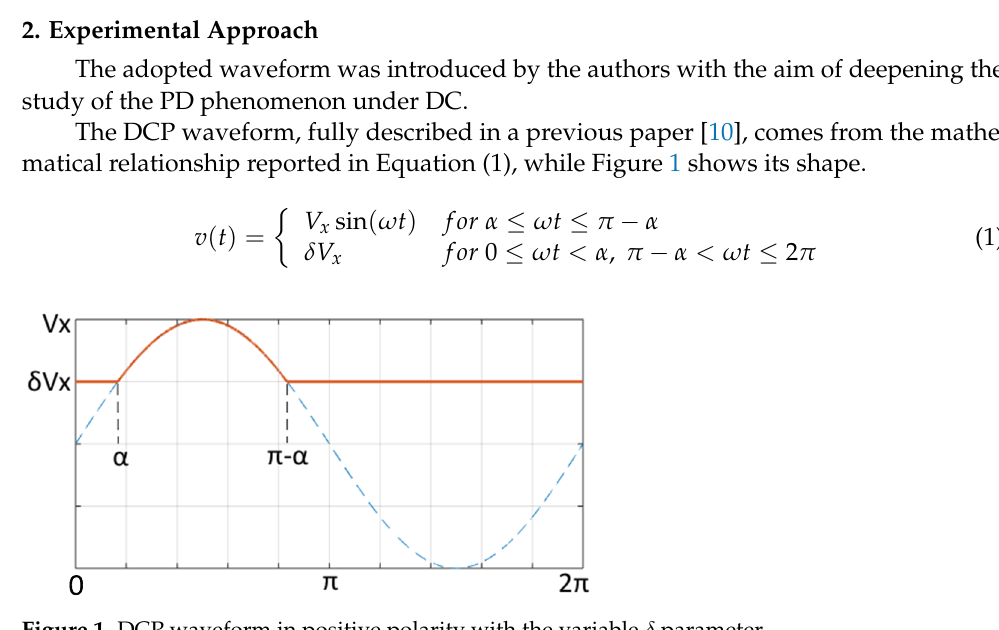
Figure 1. DCP waveform in positive polarity with the variable δ parameter.